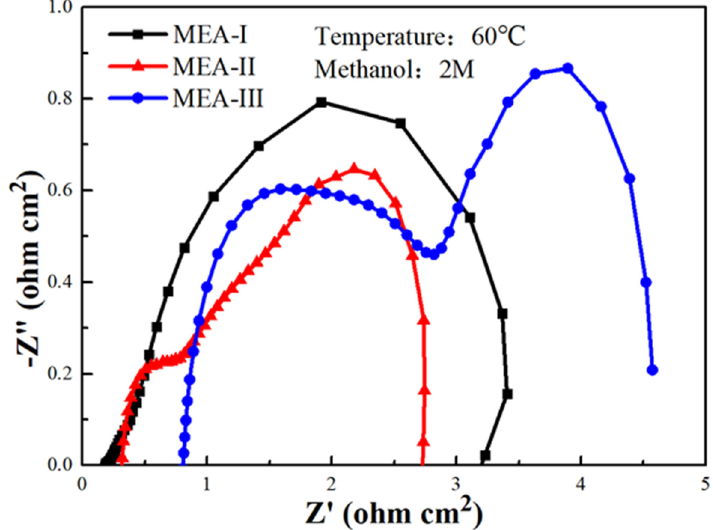
Figure 7. Impedance spectra at 0.3 V for DMFCs with different MEAs (methanol concentration 2 M, temperature 60 °C).